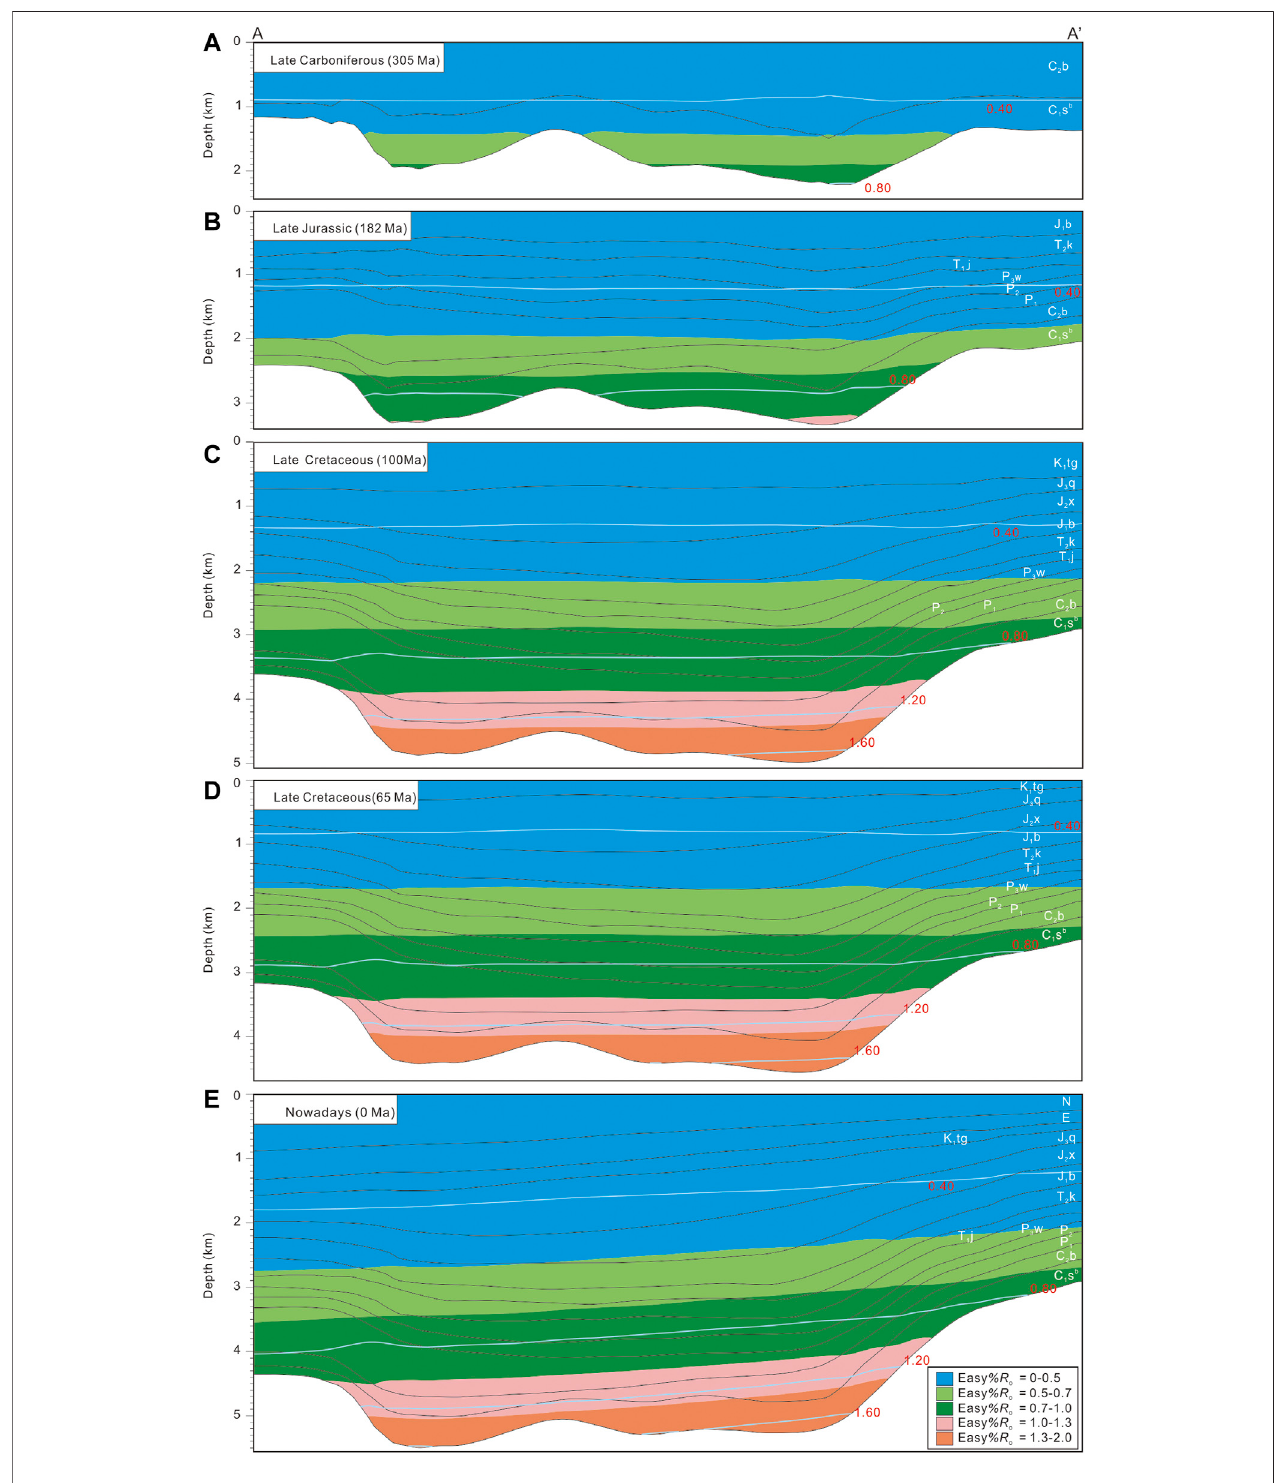
FIGURE6| Thehydrocarbongeneratingpro fi le for C 1 s b source rocks in theJimsar Sag. (A) :The thermal evolutionhistoryinthe LateCarboniferous (305 Ma). (B) : The thermal evolution history in the Late Jurassic (182 Ma); (C) : The thermal evolution history in the Late Cretaceous (100 Ma); (D) : The thermal evolution history in the Late Cretaceous (65 Ma); (E) : The thermal evolution history in nowadays (0 Ma);